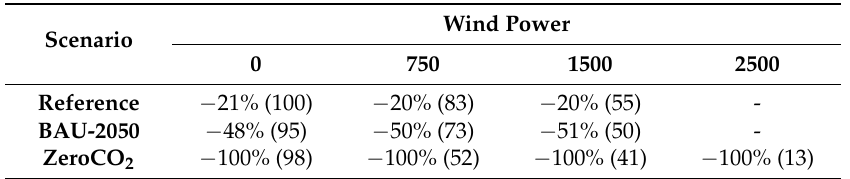
Figure 6. Power and heat production of Helsinki in the ZeroCO 2 scenario (zero-emissions). Table 4. Emissions and running costs in Helsinki for different scenarios with different levels of wind power (MW). Emissions are compared to the year 1990 level, the relative yearly running costs in brackets are compared against 2016 costs (100 = 2016 costs).